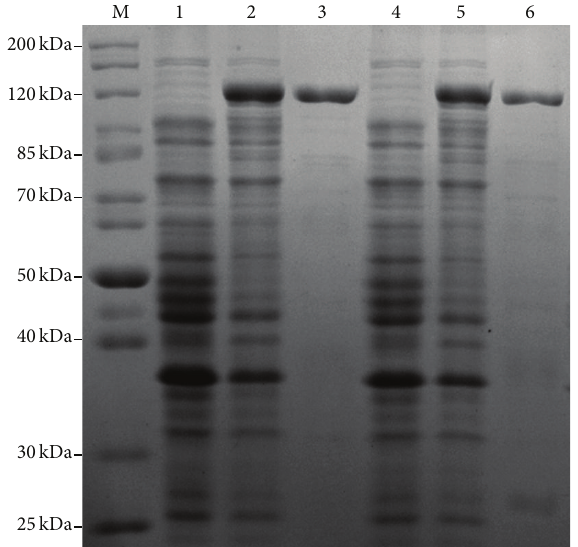
Figure 4: Coomassie stained gels showing purity of recombinant His-tagged Atl. Recombinant Atl and Atl-1 proteins were overpro- duced in E. coli and purified as described in the Materials and Methods section. Lane M: standard protein markers; lanes 1 and 2: protein extract from E. coli BL21 cells transformed with plasmids pRSETA- atl and grown without and with IPTG, respectively; lane 3: purified His-tagged Atl; lanes 4 and 5: protein extract from E. coli BL21 cells transformed with plasmids pRSETA- atl1 and grown withoutandwithIPTG,respectively;lane6:purifiedHis-taggedAtl-